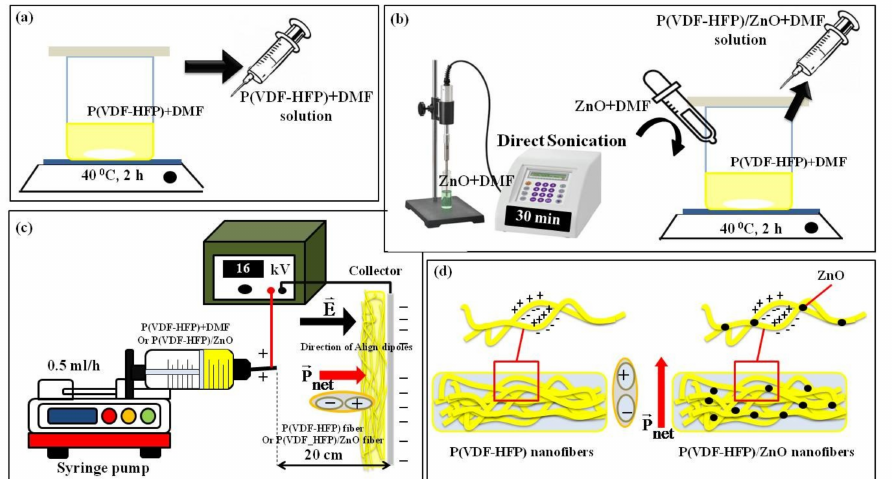
Figure 1. Schematic drawing of the samples’ preparation: ( a ) homogeneous P(VDF-HFP) solution; ( b ) homogeneous P(VDF-HFP)/ZnO solution; ( c ) the electrospinning setup; and ( d ) P(VDF-HFP) nanofibers and with ZnO